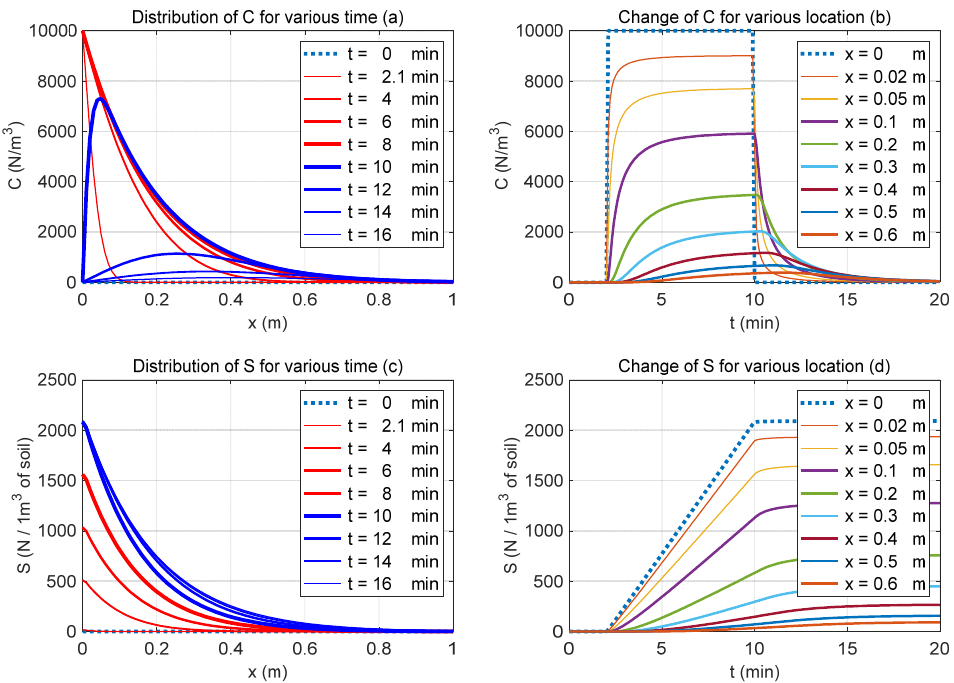
Figure 5. Simulation results for case S2 ( v = 2 v 0 ): ( a ) distribution of C at various times, ( b ) variation in C at various locations, ( c ) distribution of S at various times, and ( d ) variation in S at various locations.